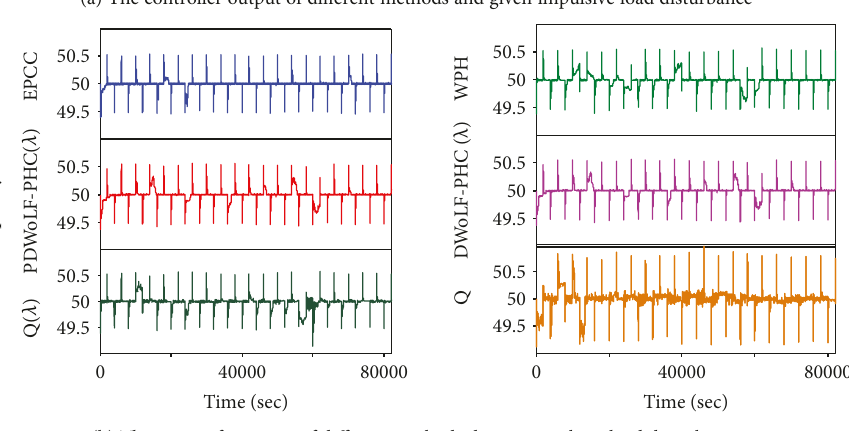
(b) The system frequency of di ff erent methods during impulsive load disturbance Figure 10: The control performance of di ff erent methods during impulsive load